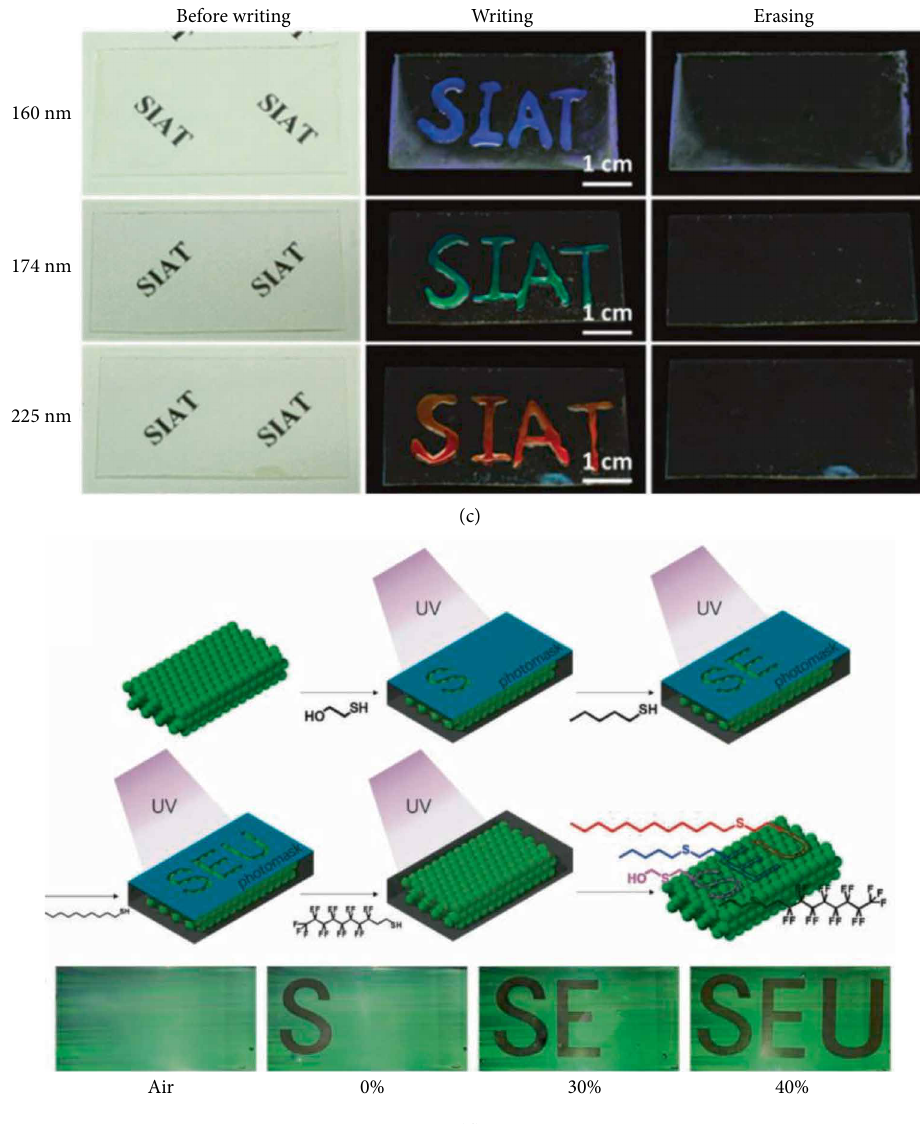
Figure 4: (a) Photonic papers were assembled from 202 nm PS beads in a PDMS matrix. Adapted from [158]. (b) Photonic papers had a uniform blue colour when observed with the naked eye and patterns were shown by the flash lamp illuminating as a point light source. Adapted from [160]. (c) Digital photo images of photonic coatings with various sizes from ca. 160 nm to ca. 225 nm on glass slides before writing (left), after writing with water (middle), and erasing by water evaporation (right). Adapted from [162]. (d) Photonic crystal film with differently patterned photomask and patterned in different concentration of ethanol aqueous solution. Adapted from